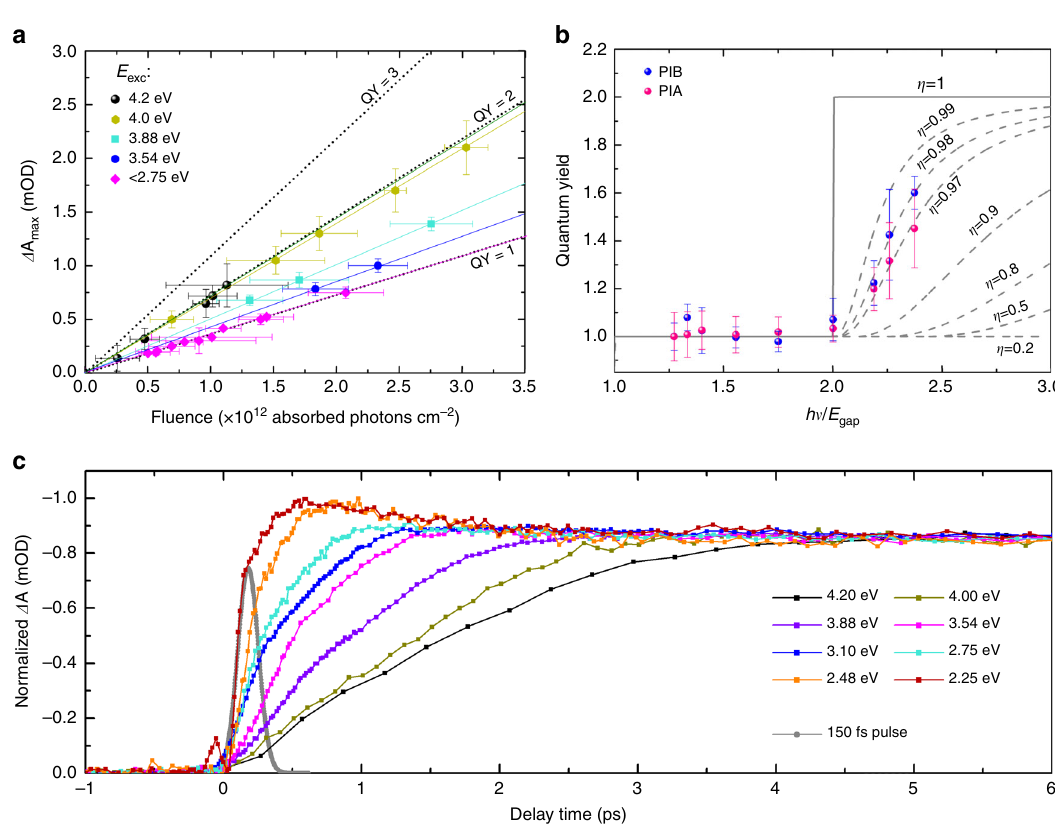
Fig. 4 Carrier multiplication ef fi ciency and Auger recombination. a Δ A as a function of the absorbed photon fl uence. The solid lines represent a linear fi t through the data points. b CM ef fi ciency plotted as a function of excitation energy normalized to the band gap energy of the CsPbI 3 nanocrystals. The blue and pink data points correspond to the yield calculated from the A / B ratios deduced from the photo-induced-bleach and -absorption respectively. c Initial rise of the photo-induced bleach signal (normalized) which becomes slower when the nanocrystals are excited with higher photon energies, and carrier multiplication sets in. The error bars are determined by small fl uctuations in the pump power ( x -direction) and from integrating the dynamics between 4 and 8 ps yielding an upper and lower limit for Δ A ( y